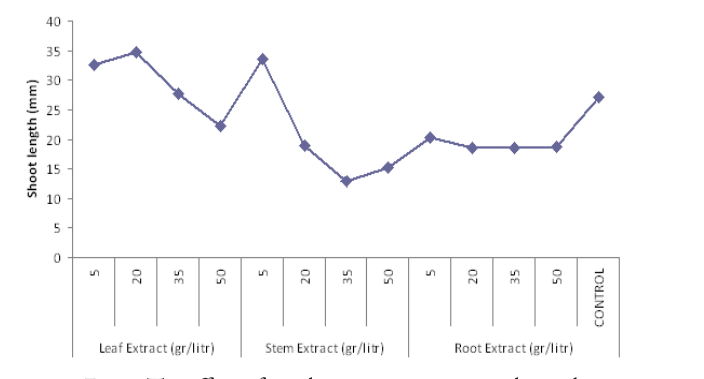
Fig. 5. The effect of sorghum extract on mung bean shoot